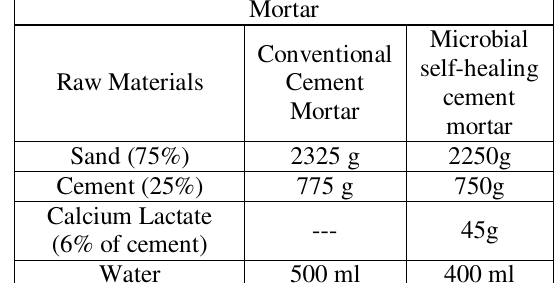
Table 1: Amount of Raw Material for Conventional and Microbial Self-Healing Cement Mortar Microbial Conventional self-healing Raw Materials Cement Mortar